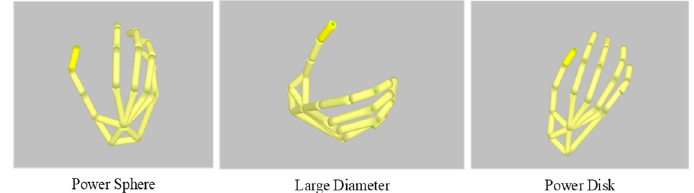
Figure 14. Grasping motions predicted from captured data.